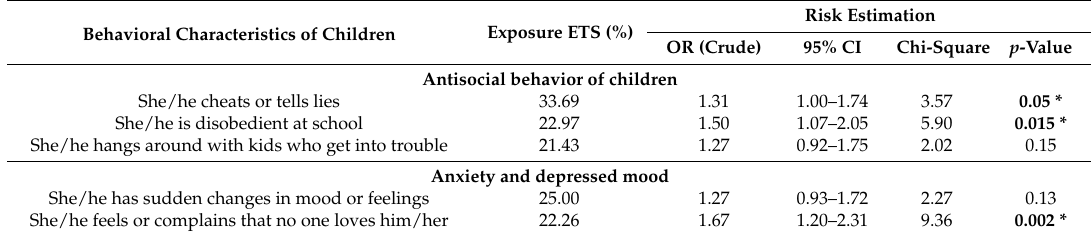
Table 5. Behavioral characteristics of children (BPI) and mother’s smoking † ( n = 1373) (bivariate analysis).